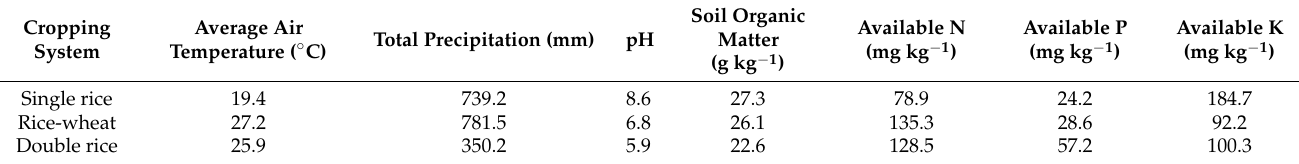
Table 1. Weather conditions and initial soil